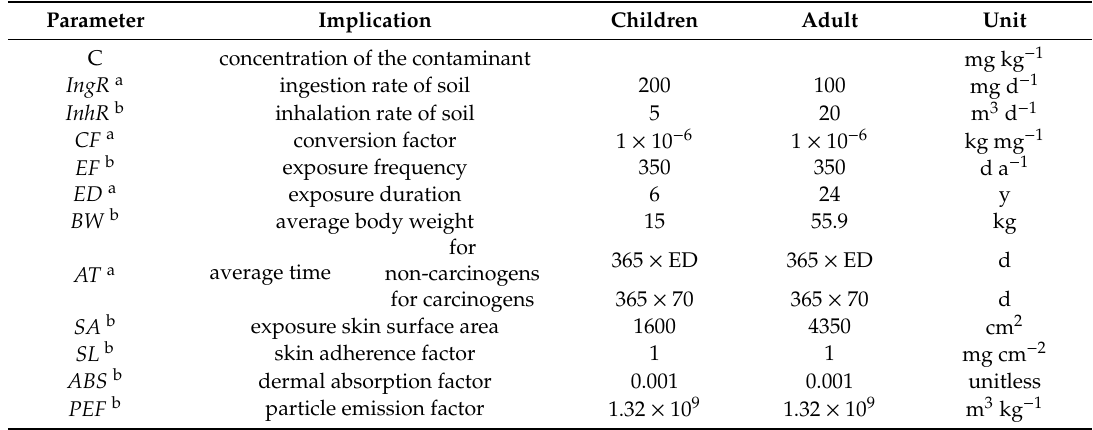
Table 1. Parameters for the exposure risk calculations for heavy metals.